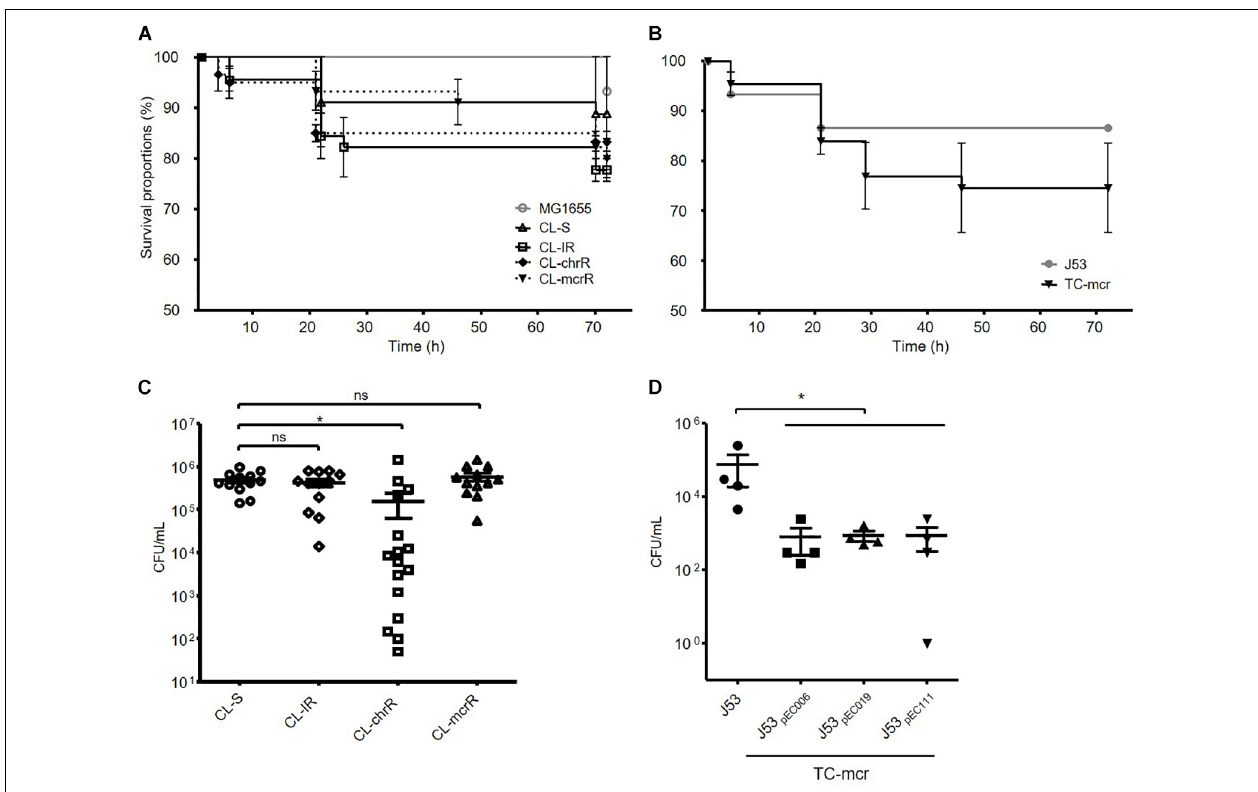
FIGURE 7 | Results of fruit fly ( D. melanogaster ) infections. (A,B) Survival rates of flies infected with bacterial isolates obtained after incubation for 15 h. 15 flies were infected with each strain. (C,D) Number of surviving colonies of bacteria in the flies after 72 h of infection. Four fruit flies were used for each strain, and dots indicate CFUs in a single fly. The error bars indicate the standard deviations. Statistics were conducted with unpaired, two-tailed t -tests. * P ≤ 0.05; ns, not